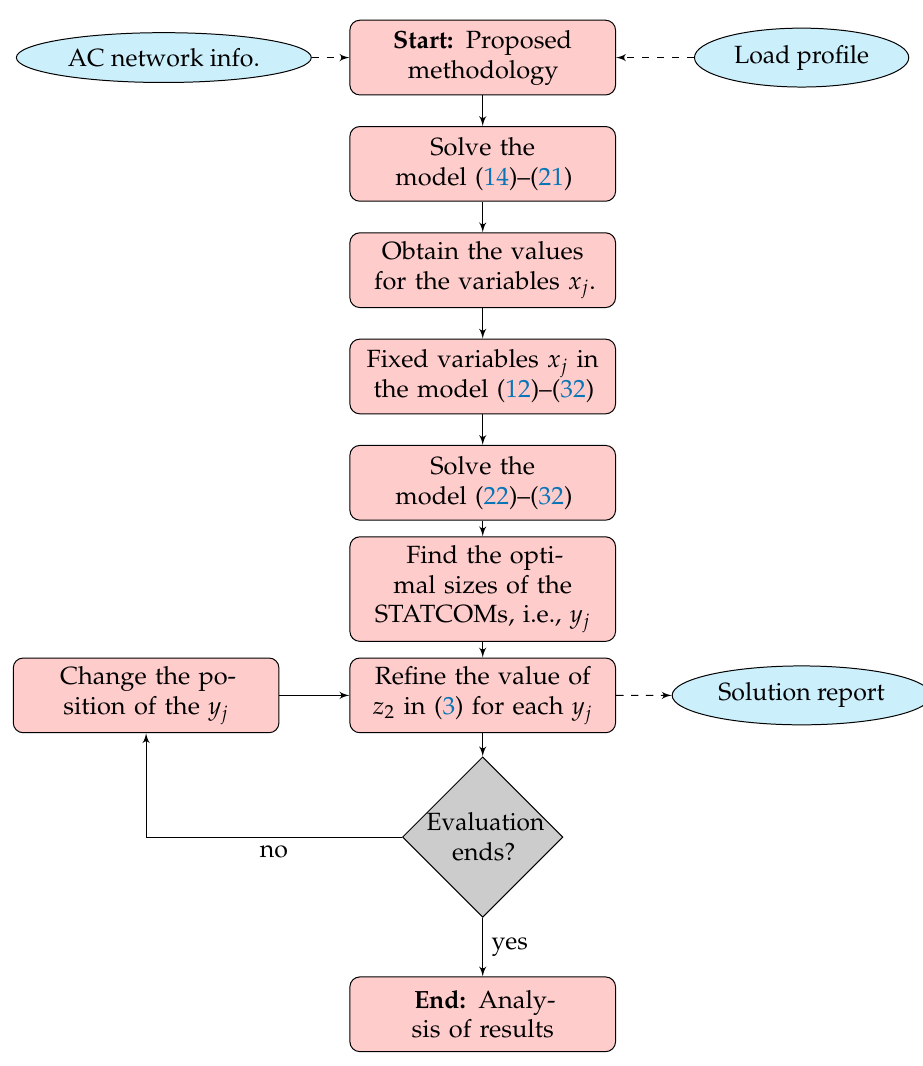
Figure 1. Main aspects of the proposed solution